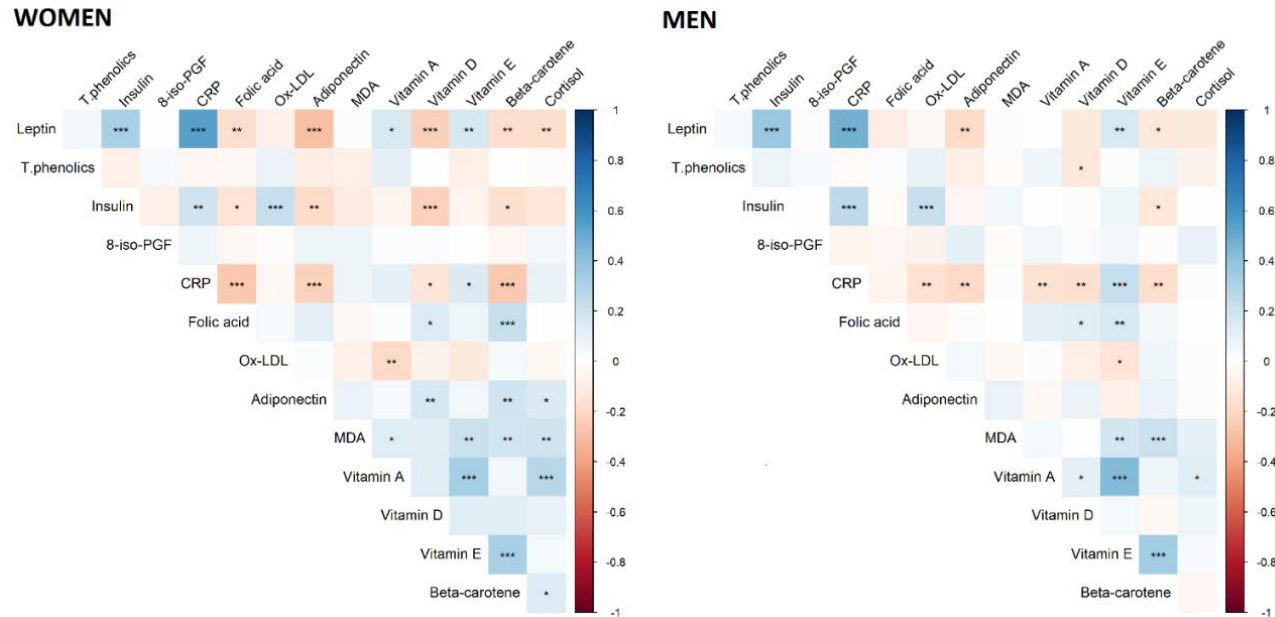
Figure 3. Correlations between micronutrients and markers of inflammation and oxidative stress. * p -value < 0.05; ** p -value < 0.01; *** p -value < 0.001. T.phenolics: total phenolics; MDA: malondialdehyde; Ox-LDL: oxidized low-density lipoprotein; CRP: c-reactive protein; 8-iso-PGF: 8-iso-prostaglandin-F2α. All concentrations were natural log-transformed with the exception of vitamin A, MDA, and cortisol. Table 3. Variables selected by the LASSO logistic regression, measuring the association between metabolic syndrome and micronutrients and markers of inflammation and oxidative stress (N =